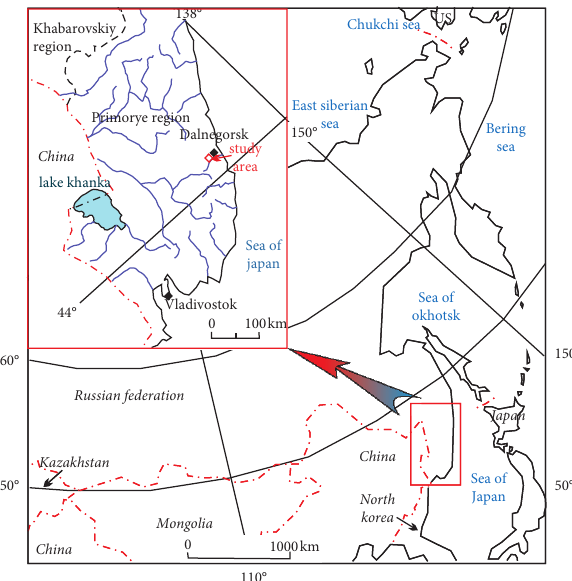
Figure 1: The location of the study